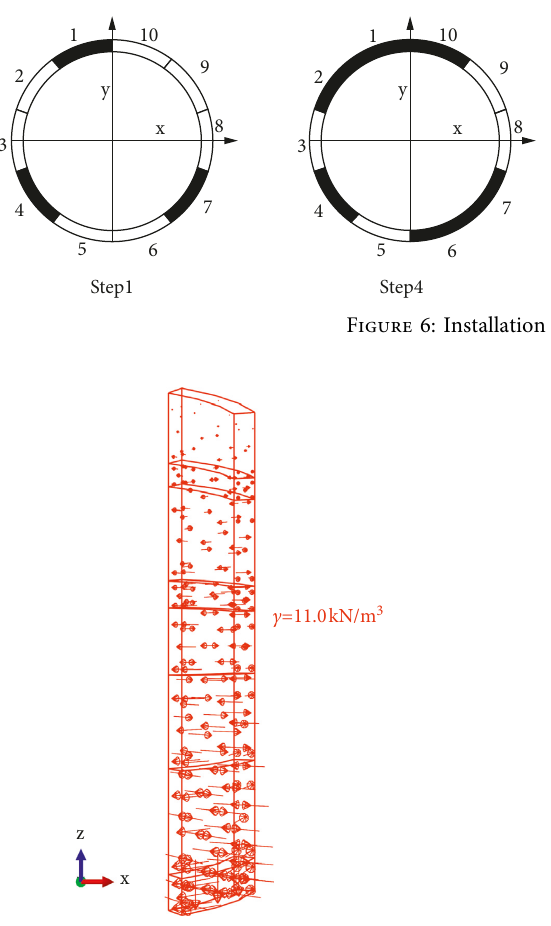
Figure 7: Bentonite grouting pressure.